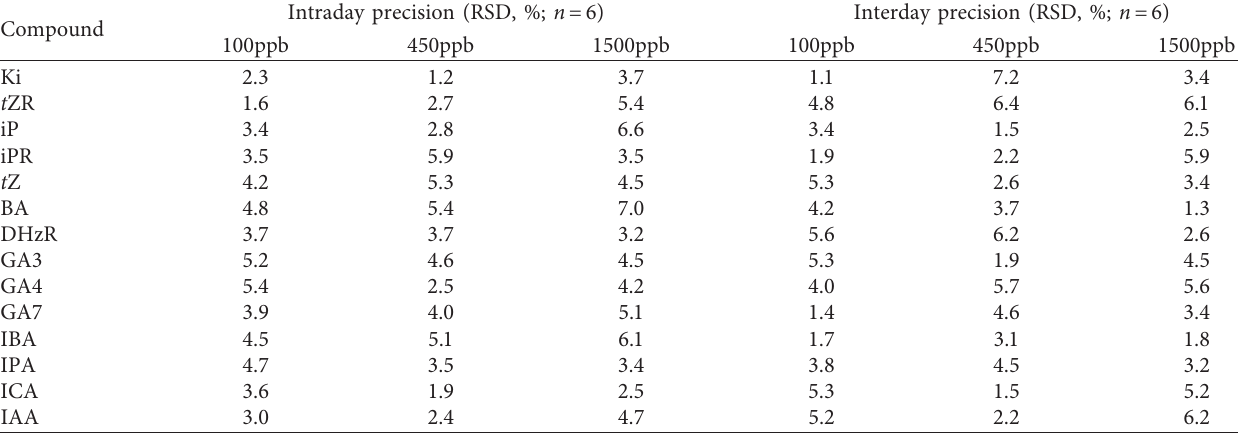
Table 2: Intra- and interday precisions of the HPLC-ESI-MS/MS method ( n � 6). Compound